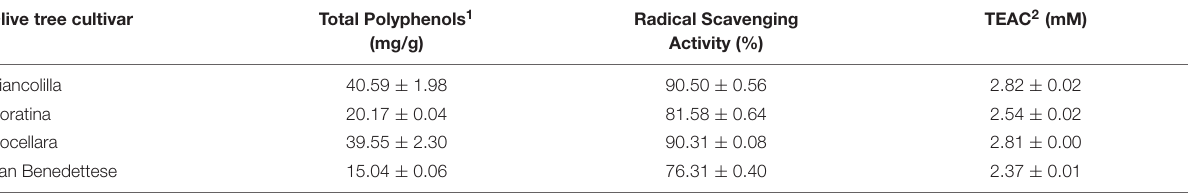
TABLE 2 | Total polyphenol content, radical scavenging activity, and Teac from different OLE cultivars. Olive tree cultivar